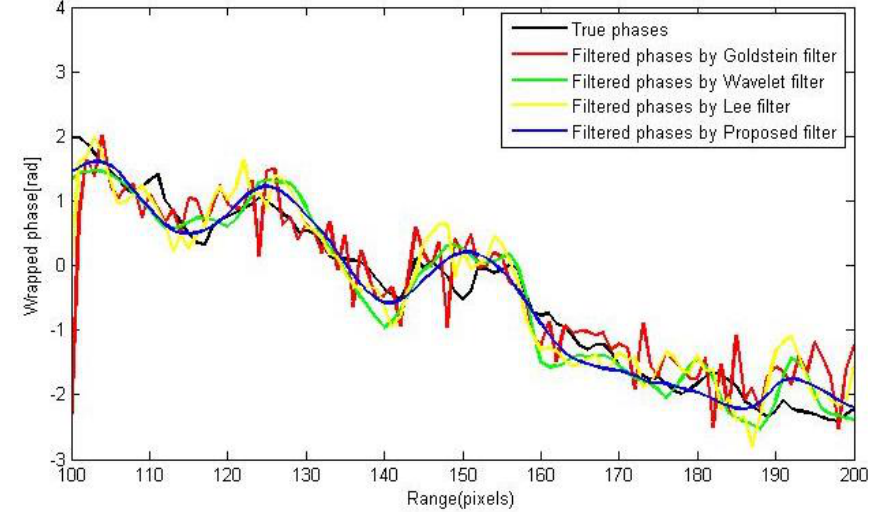
Figure 6. Cross-section over the phases filtered by the Goldstein filter, wavelet filter, Lee filter and the proposed filter. The location of the cross-section is shown in Figure 5(a1–d1).